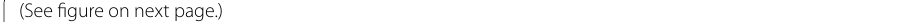
figure on next Fig. 2 HBx downregulated the expression of key proteins in the DNA MMR and pyruvate metabolism systems. a‑b Downregulated proteins (blue) played vital roles in the DNA MMR and pyruvate metabolism systems. MLH1, replication factor C (RFC) and replication protein A1(RPA) in the DNA MMR system, and dihydrolipoamide S-acetyltransferase, lactate dehydrogenase, pyruvate dehydrogenase, acetyl-CoA acetyltransferase and aldehyde dehydrogenase in the pyruvate metabolism system were downregulated. c Fold-change downregulation of HBx in HepG2 cells. All proteins was investigated by pathway analysis mapping genes to KEGG